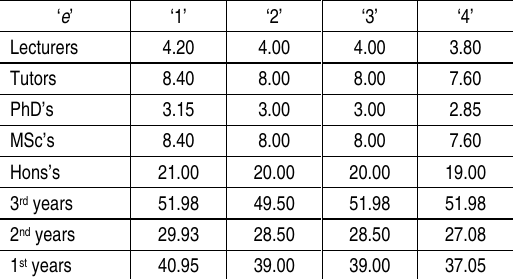
Table 1a. Observed and expected people capacity and practice for SOR business